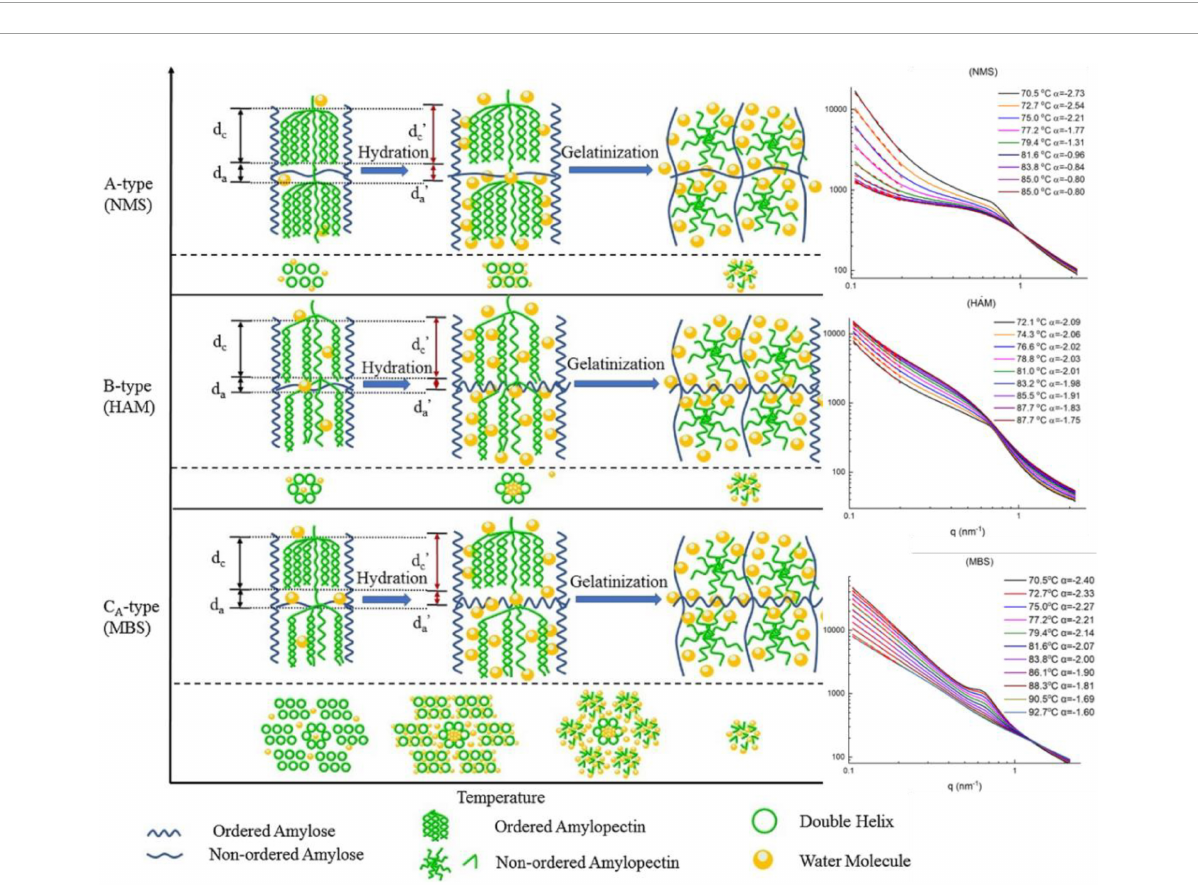
FIGURE6 (Left) Schematic representation of lamellar and crystalline structural dynamics during heating. The two steps are shown: hydration, which is the uptake of water and swelling of starch granules; gelatinization, which is the disruption of starch crystal structure. (Right) Small-angle X-ray